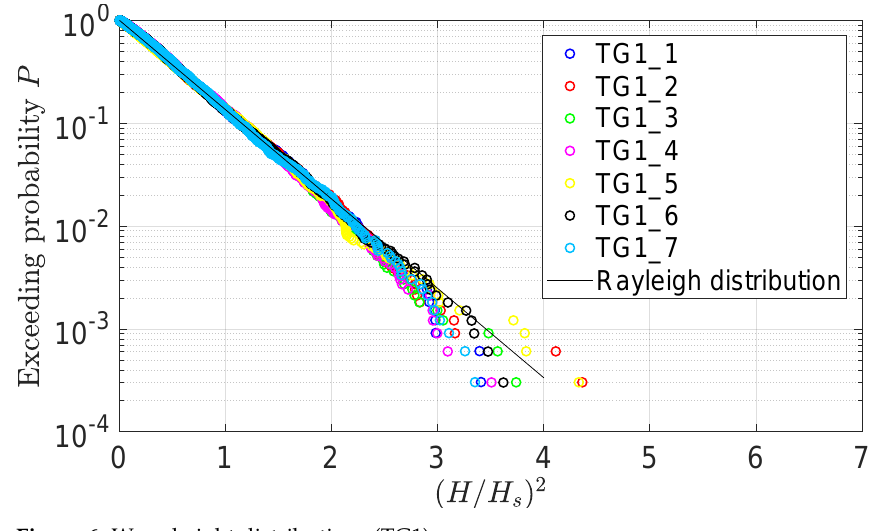
Figure 6. Wave height distributions (TG1).